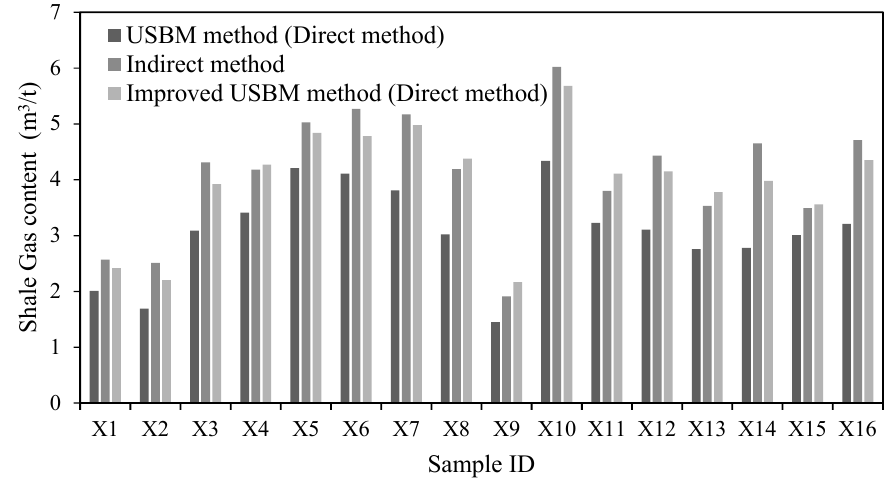
Figure 12. A comparison of shale gas content between the USBM method, the improved USBM method and the indirect method.